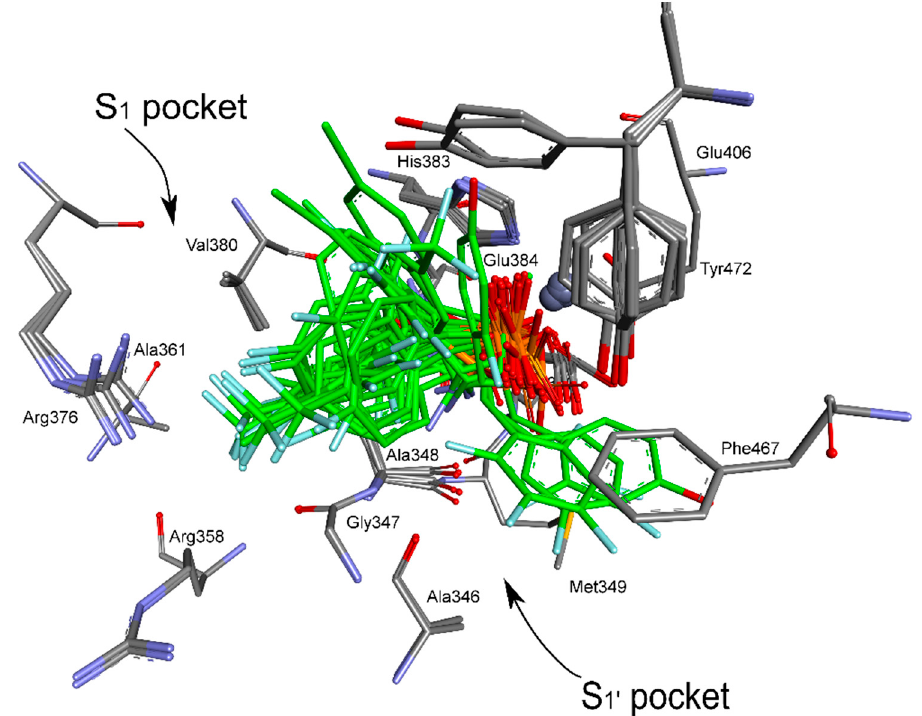
Figure 1. Modes of binding of all the studied analogs of phenylglycine (both enantiomers shown for each compound) by porcine aminopeptidase (pAPN). The carbon and chlorine atoms of inhibitors are colored green, phosphonate oxygen atoms in red, and the amine group in blue. Fluorine is indicated as light blue. The zinc ion is shown as a grey sphere.